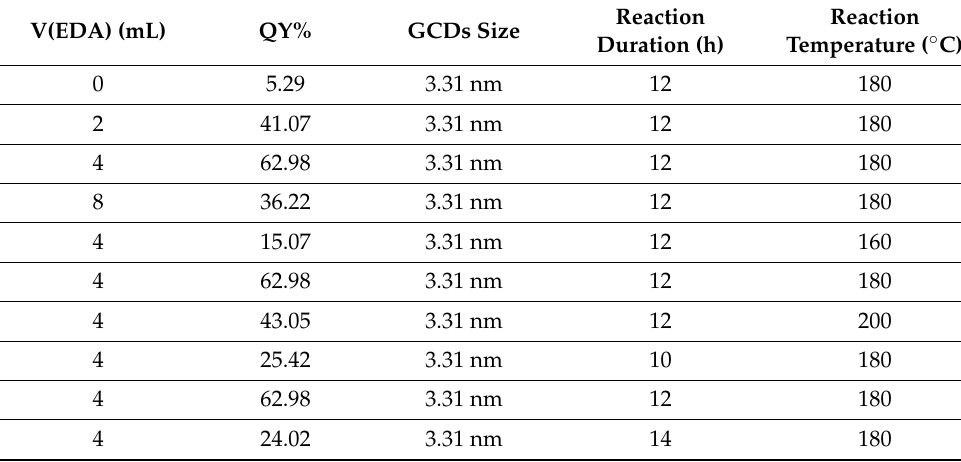
Table 2. GCDs quantum yield (QY) values under different reaction conditions [34].